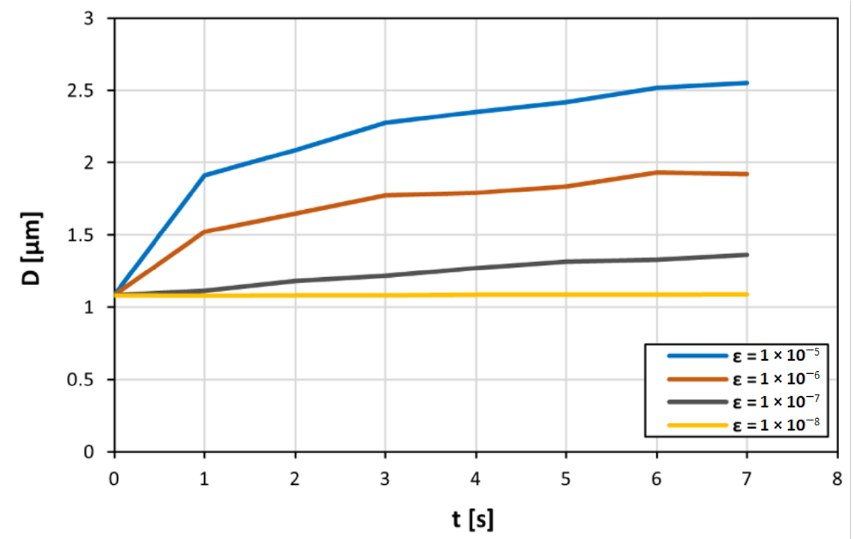
Figure 4. Dependence of the average size of particle agglomerates on the pair potential values between ε = 10 − 8 J and ε = 10 − 5 J as the simulation is